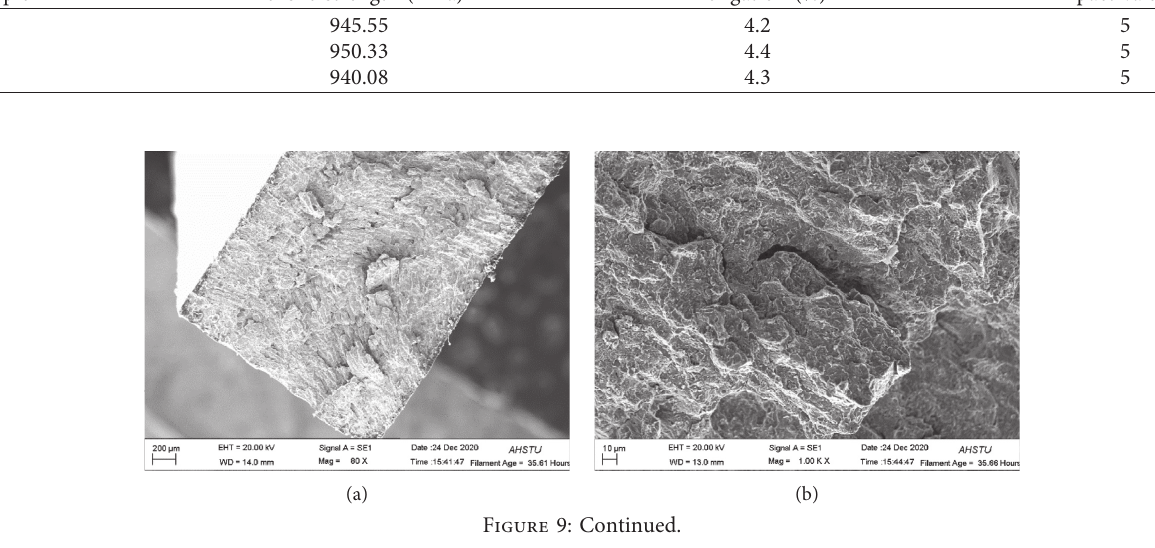
Figure 8: Microhardness distribution of the sample prepared by Table 3: Tensile strength, elongation, and room temperature Charpy shock impact values of the steel samples manufactured by WAAM. Sample